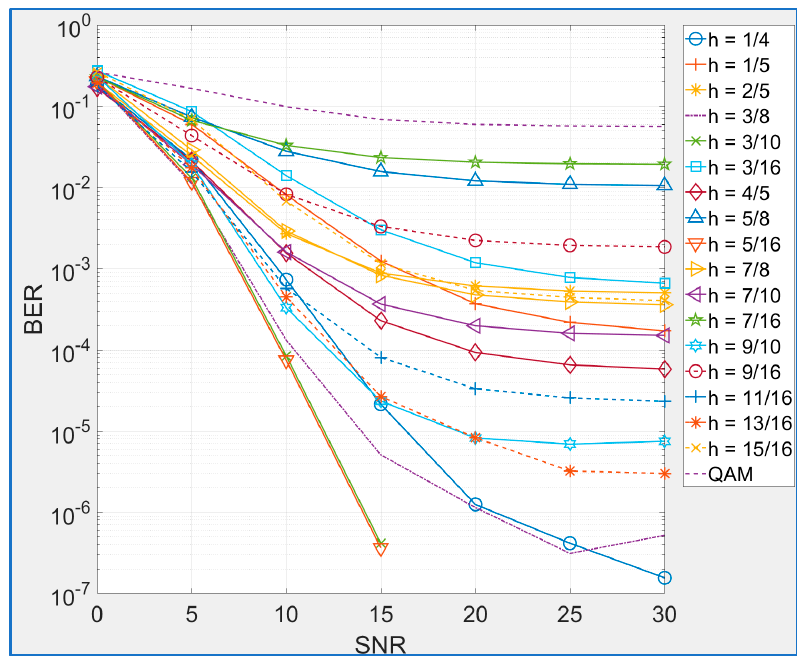
Figure 10. BER performance of CPM-GFDM vs. QAM-GFDM with J = 8 for matched filter receiver Figure 10 . BER performance of CPM-GFDM vs. QAM-GFDM with 𝐽 = 8 for matched filter receiver over AWGN over AWGN channels.